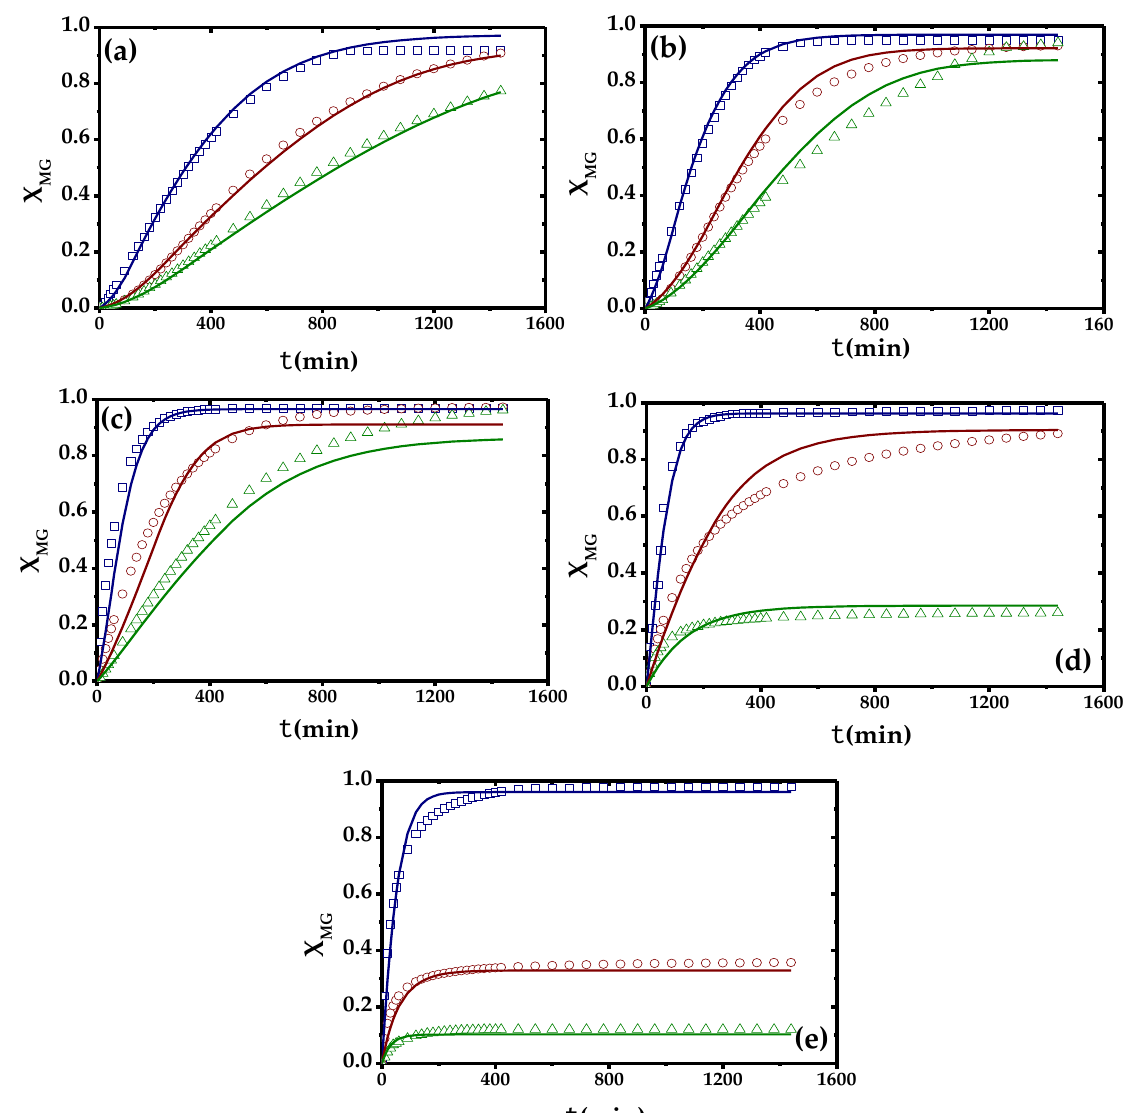
Figure 6. Fitting of Model 2 to all experimental data (ibuprofen concentrations: □ 20 g · L −1 ; Ο 60 g · L −1 ; Δ 100 g · L −1 ), at ( a ) 50, ( b ) 60, ( c ) 70, ( d ) 75 and ( e ) 80 °C. Open symbols are experimental data; lines are data estimated with the model.